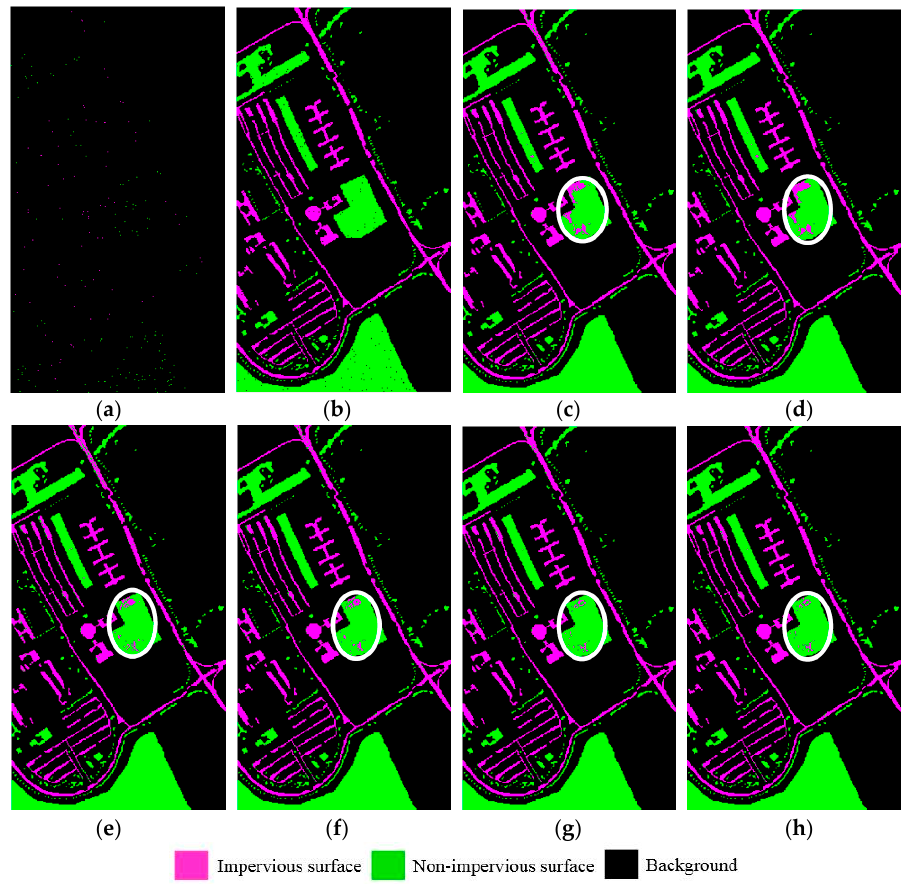
Figure 7. University of Pavia image: ( a ) training data; and ( b ) test data. Estimation maps obtained by: ( c ) SPE-SVM; ( d ) SS-SVM; ( e ) SPE-RF; ( f ) SS-RF; ( g ) SPE-SR; and ( h ) SS-SR. Table 3. Accuracy assessment for University of Pavia image.